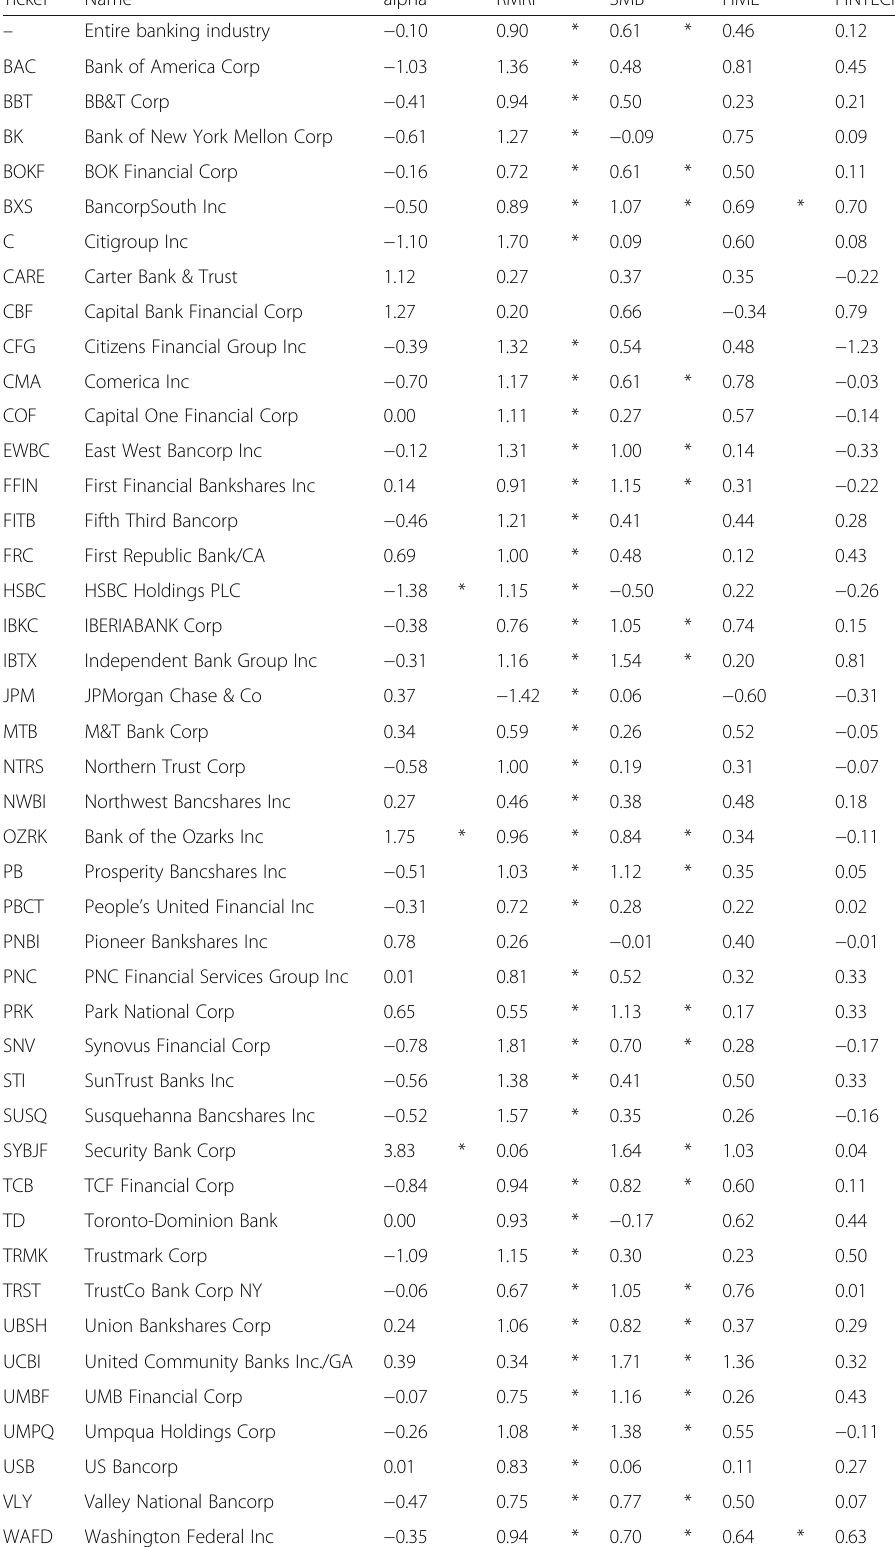
Table 5 OLS Regression Results of Models with FinTech Volume